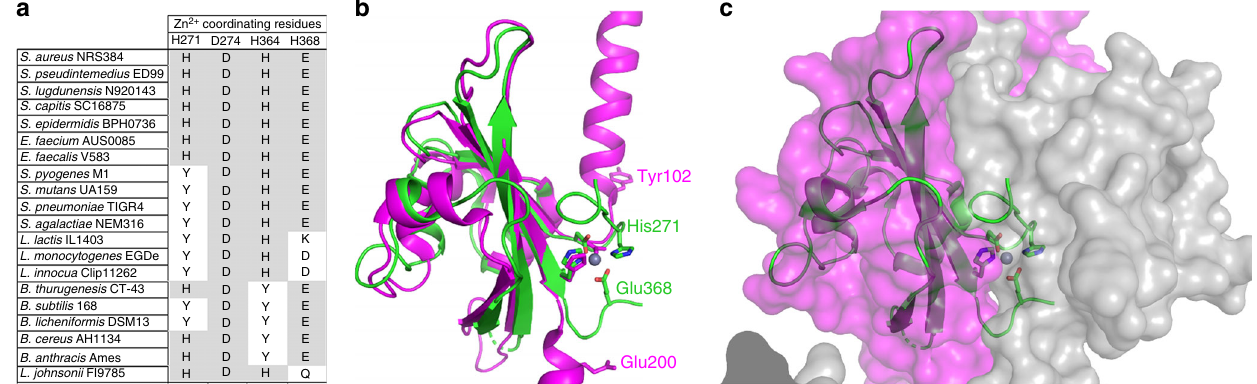
Fig. 6 Structural comparison of WalK. a Comparison of metal-coordinating residues from a range of Gram-positive bacteria with WalK orthologues. Protein sequences were aligned with ClustalW using default parameters. Residues that match the S. aureus consensus are highlighted in grey. b Superposition of the crystal structure of WalK-PAS FULL (green) with VicK (magenta, PDB: 4I5S) in cartoon representation. The Zn 2 + -coordinating residues in WalK- PAS FULL are shown as sticks, with the homologous residues in VicK shown in magenta. The bound Zn 2 + ion is shown as a sphere. c Superposition of WalK- PAS FULL (green) with the VicK 2 homodimer shown by transparent surface representation (magenta/grey, PDB: 4I5S). The crystal structure of WalK- PAS FULL is shown by cartoon representation with the Zn 2 + -binding site metal-coordinating residues shown as sticks and the bound ion as a